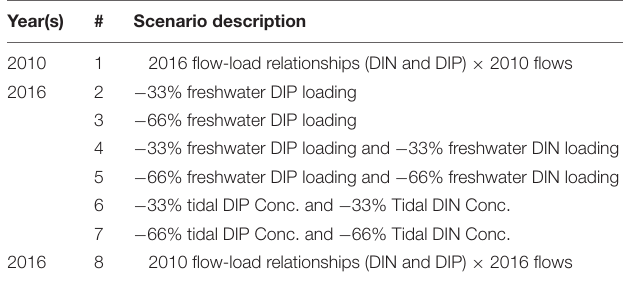
TABLE 5 | Scenarios considered in nutrient load scenario